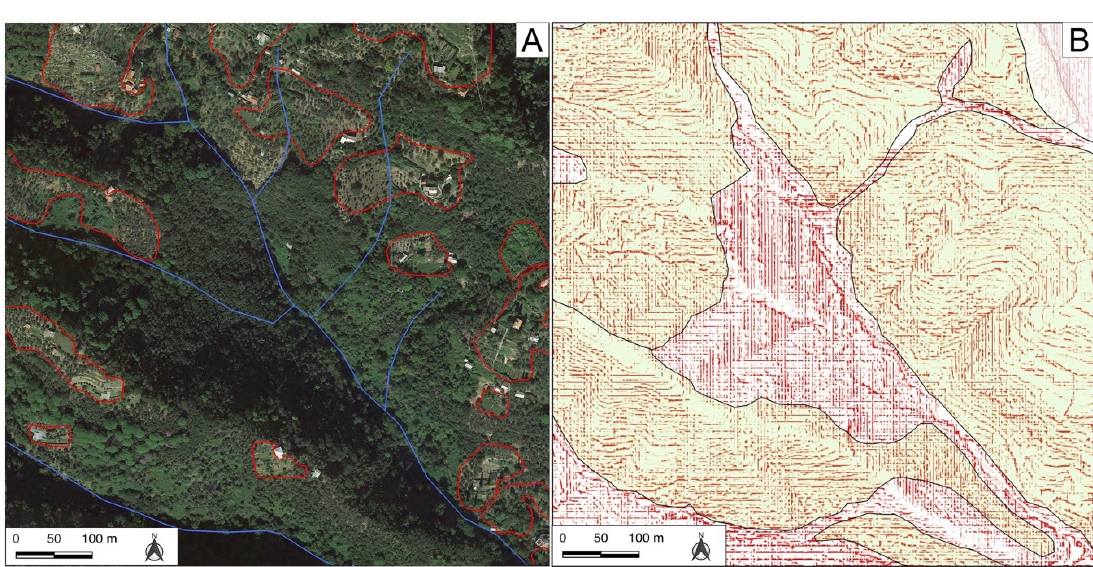
Figure 6. The detected terraces after Sky View Factor computation.